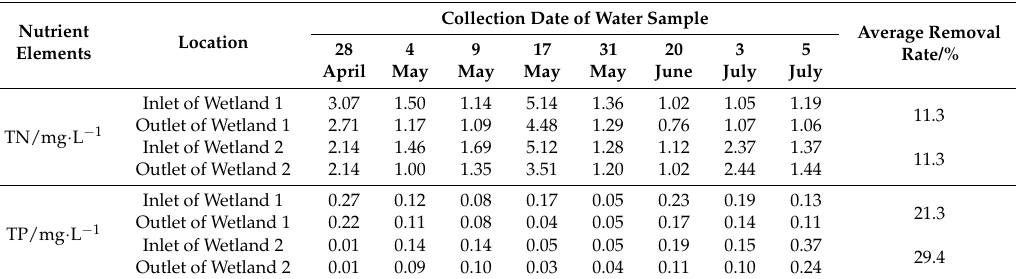
Table 5. Purification of total nitrogen and total phosphorus in pond wetlands during the early rice growth period.